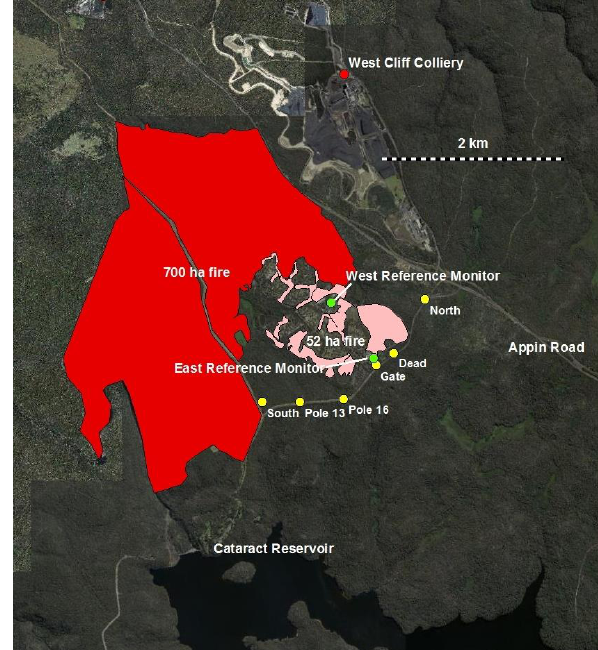
Figure 1. Location of the fires (red polygons) and relevant land- marks. Green dots are permanent air quality monitors; white dots are readings from handheld air quality monitor. Black dots are other landmarks. The background is elevation.